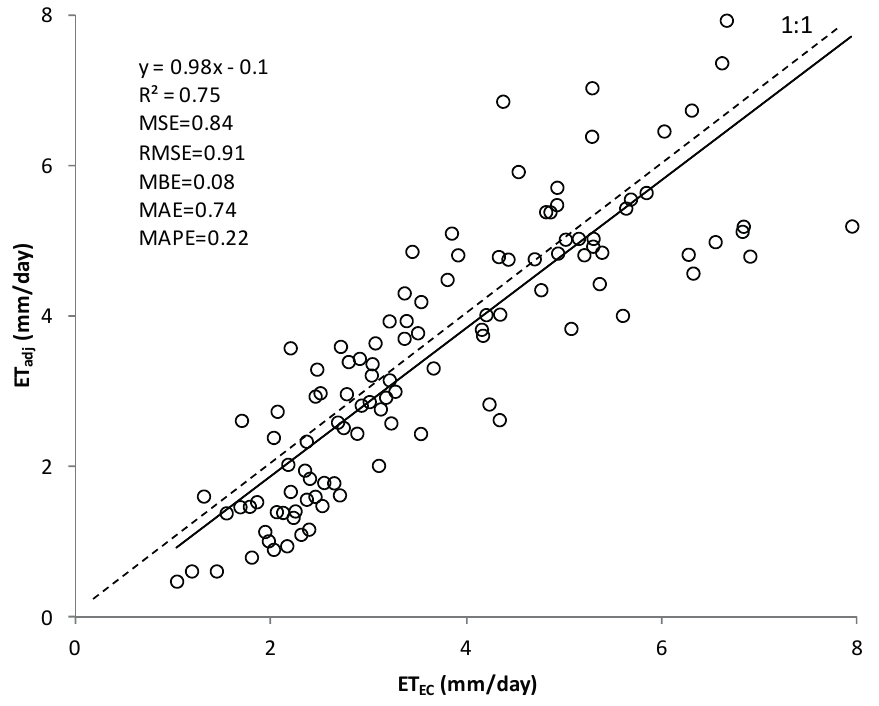
Figure 7. Comparison between the daily values of estimated (cid:1831)(cid:1846) by the FAO-56 model (cid:3028)(cid:3031)(cid:3037) and the measured one ((cid:1831)(cid:1846) ) by the Eddy-covariance system for the experimental plot. (cid:3006)(cid:3004) Error indicators are MSE (Mean Square Error), RMSE (Root Mean Square Error), MBE (Mean Bias Error), MAE (Mean Absolute Error) and MAPE (Mean Absolute Percentage